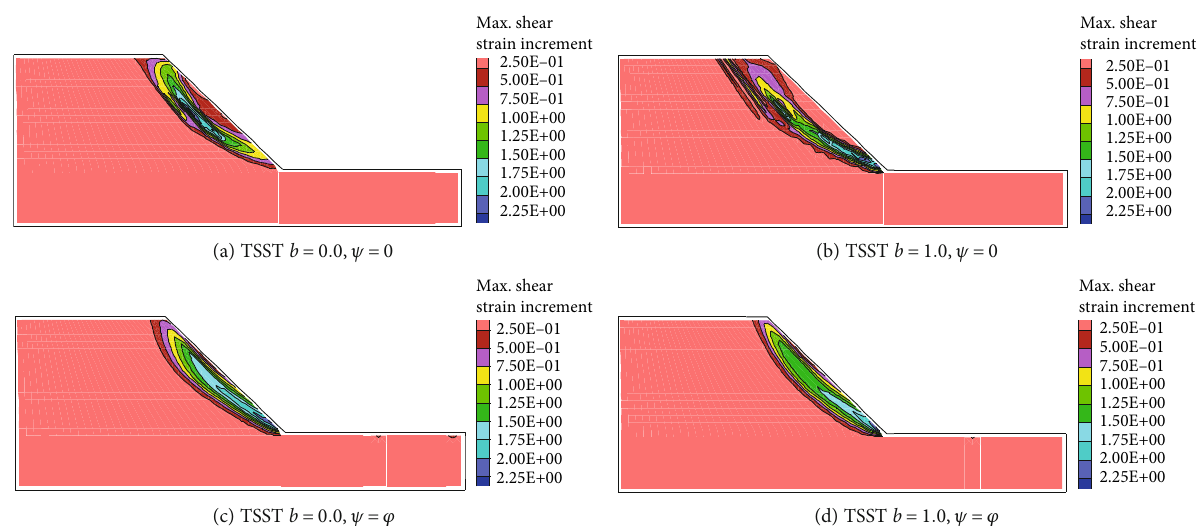
Figure 5: Maximum shear strain contours of slope (unsaturated seepage) when the water level drops to L / H = 1 : 0 .